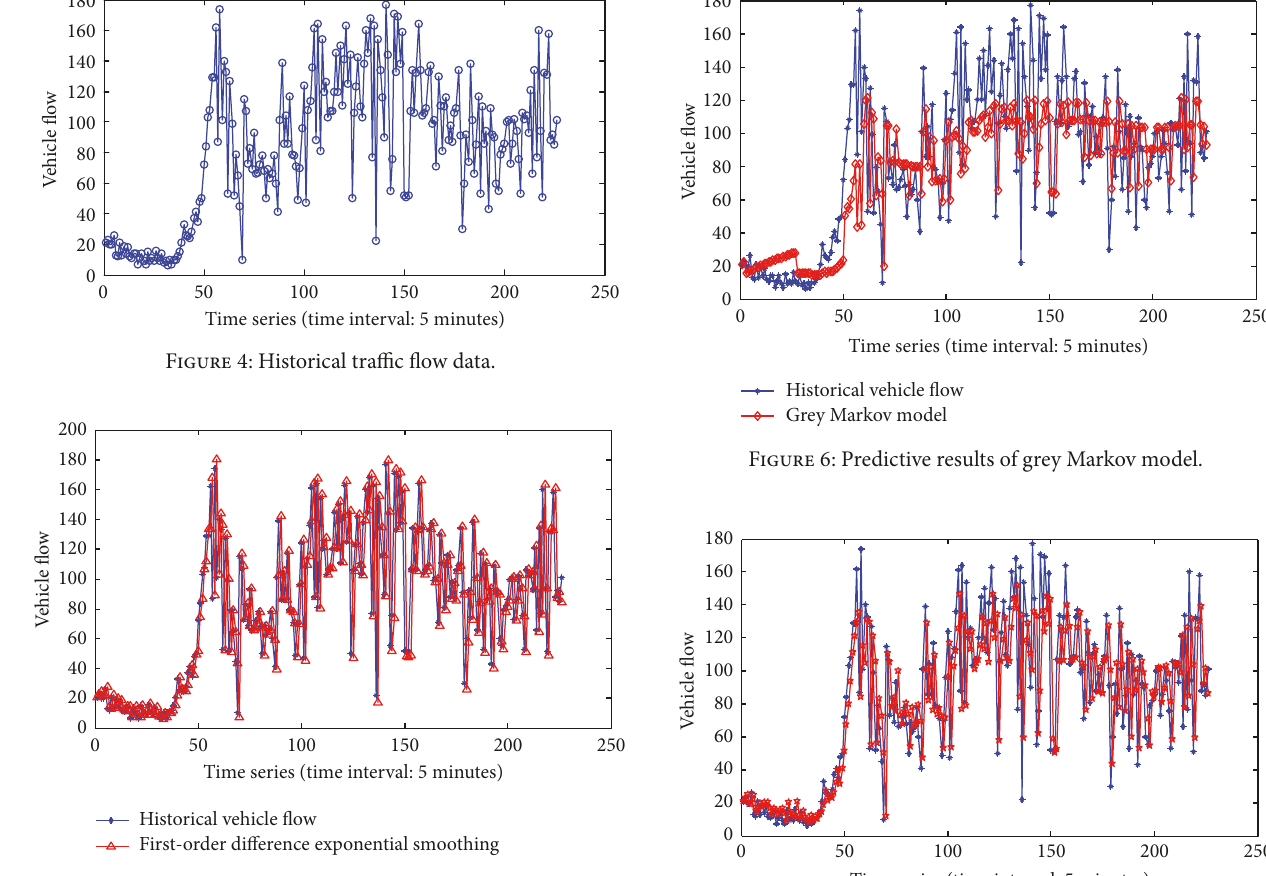
Figure 5: Predictive results of first-order difference exponential smoothing model.